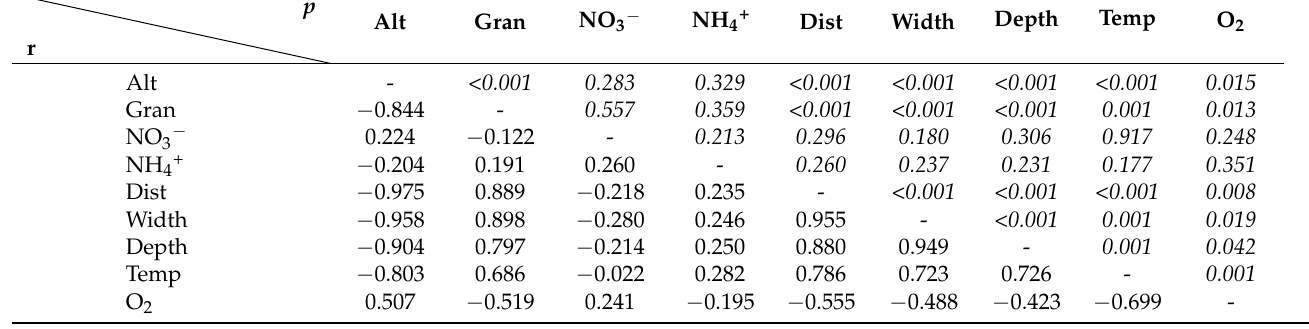
Table 3. Spearman (r) correlations among environmental variables (low half) and their p -values in italics (upper half).